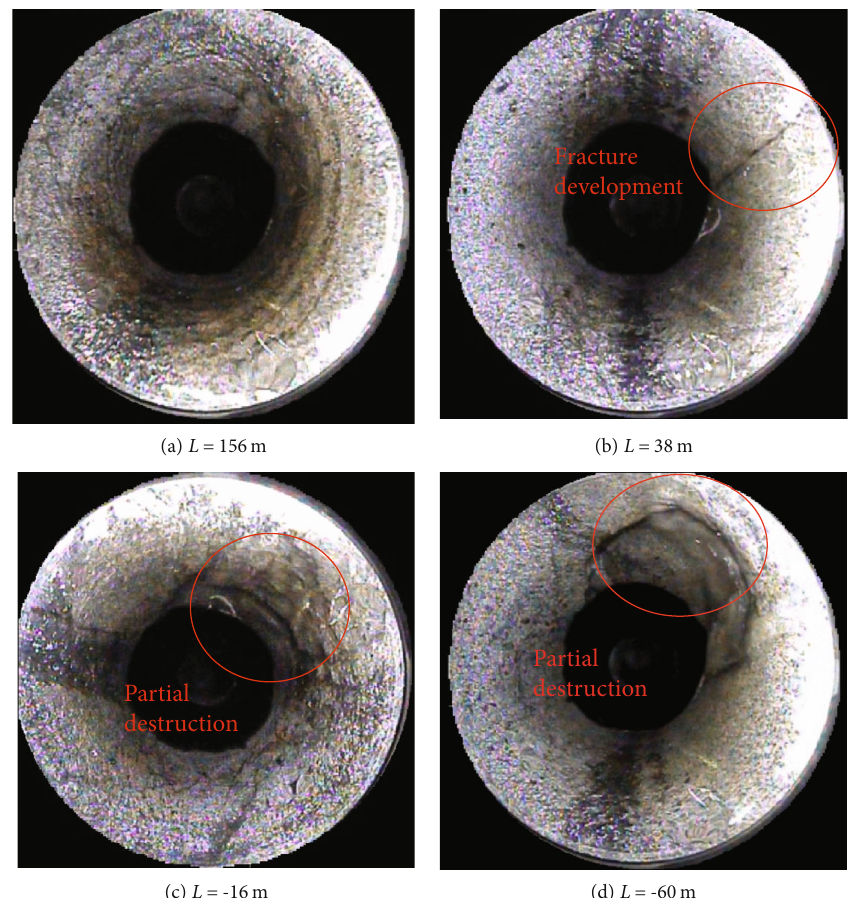
Figure 8: Image of damage and deformation at the vertical depth of